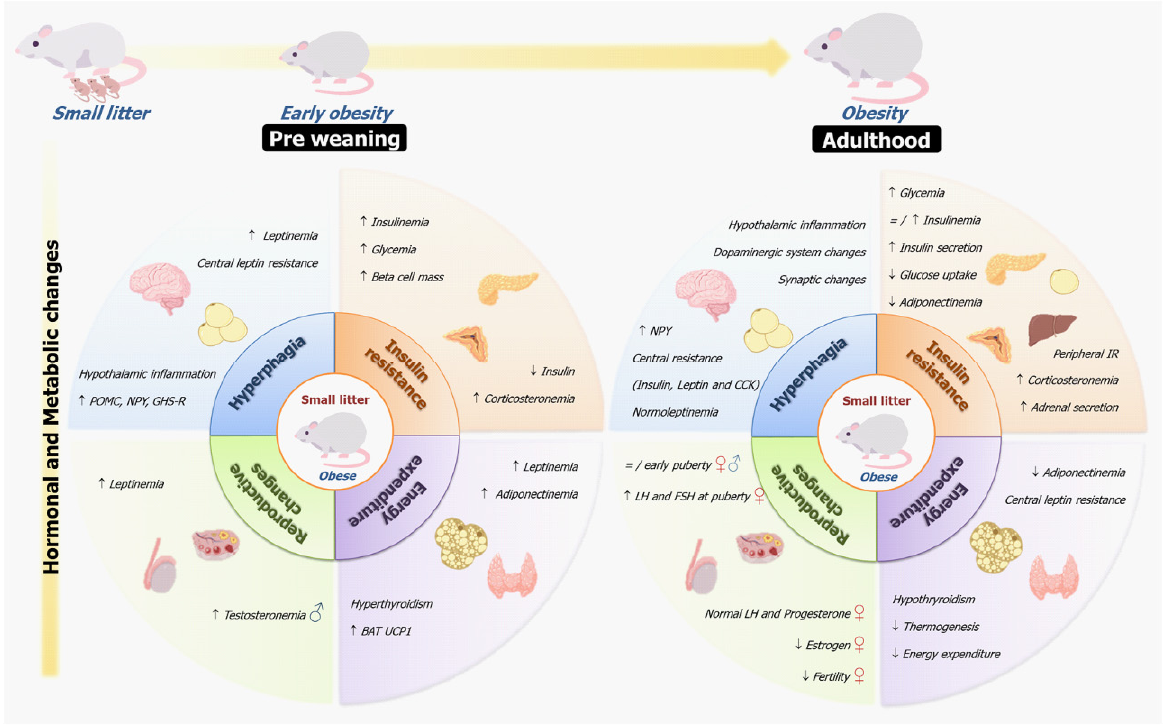
Figure 3. Early and late endocrine and metabolic changes in offspring raised in small litters that explain the development of the obese phenotype. Several hormonal and metabolic changes are involved in hyperphagia, insulin resistance, energy expenditure, and reproductive changes in small litter offspring. There are adaptive responses from preweaning to adulthood that contribute to the obesity phenotype of these animals. Legend: CCK, cholecystokinin; IR, insulin resistance; BAT, brown adipose tissue; UCP1, uncoupled protein 1; POMC, pro-opiomelanocortin; NPY, neuropeptide Y; GHS-R, ghrelin receptors; LH, luteinizing hormone; FSH, follicle-stimulating hormone.